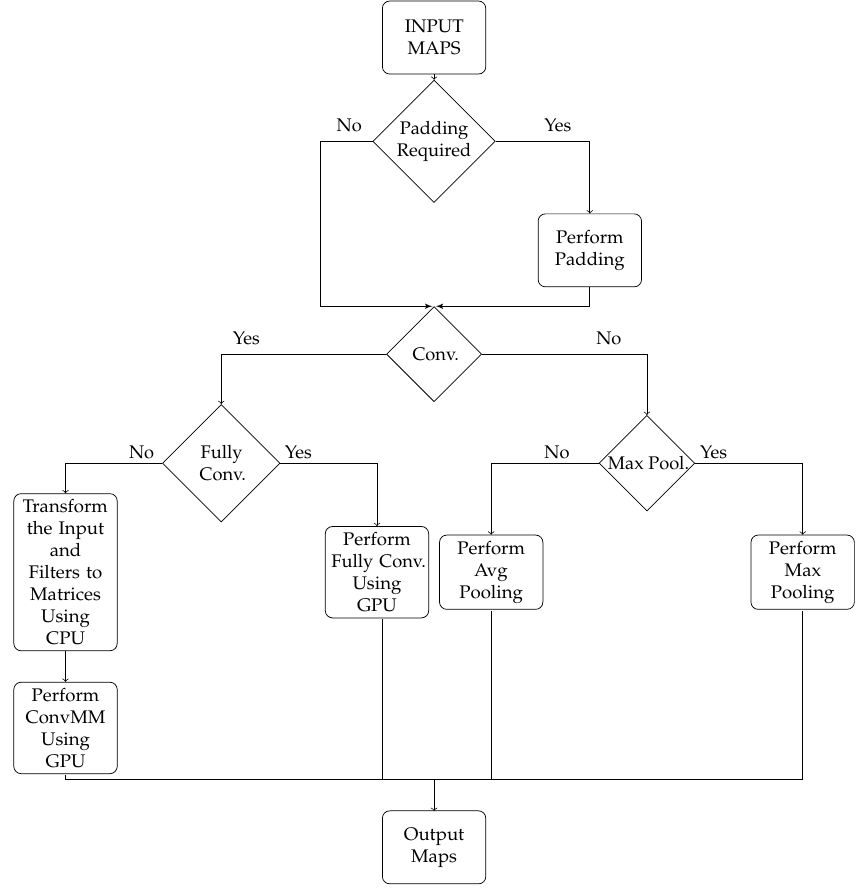
Figure 4. Flow of the convolutional and pooling layers. ConvMM, Convolution Matrix